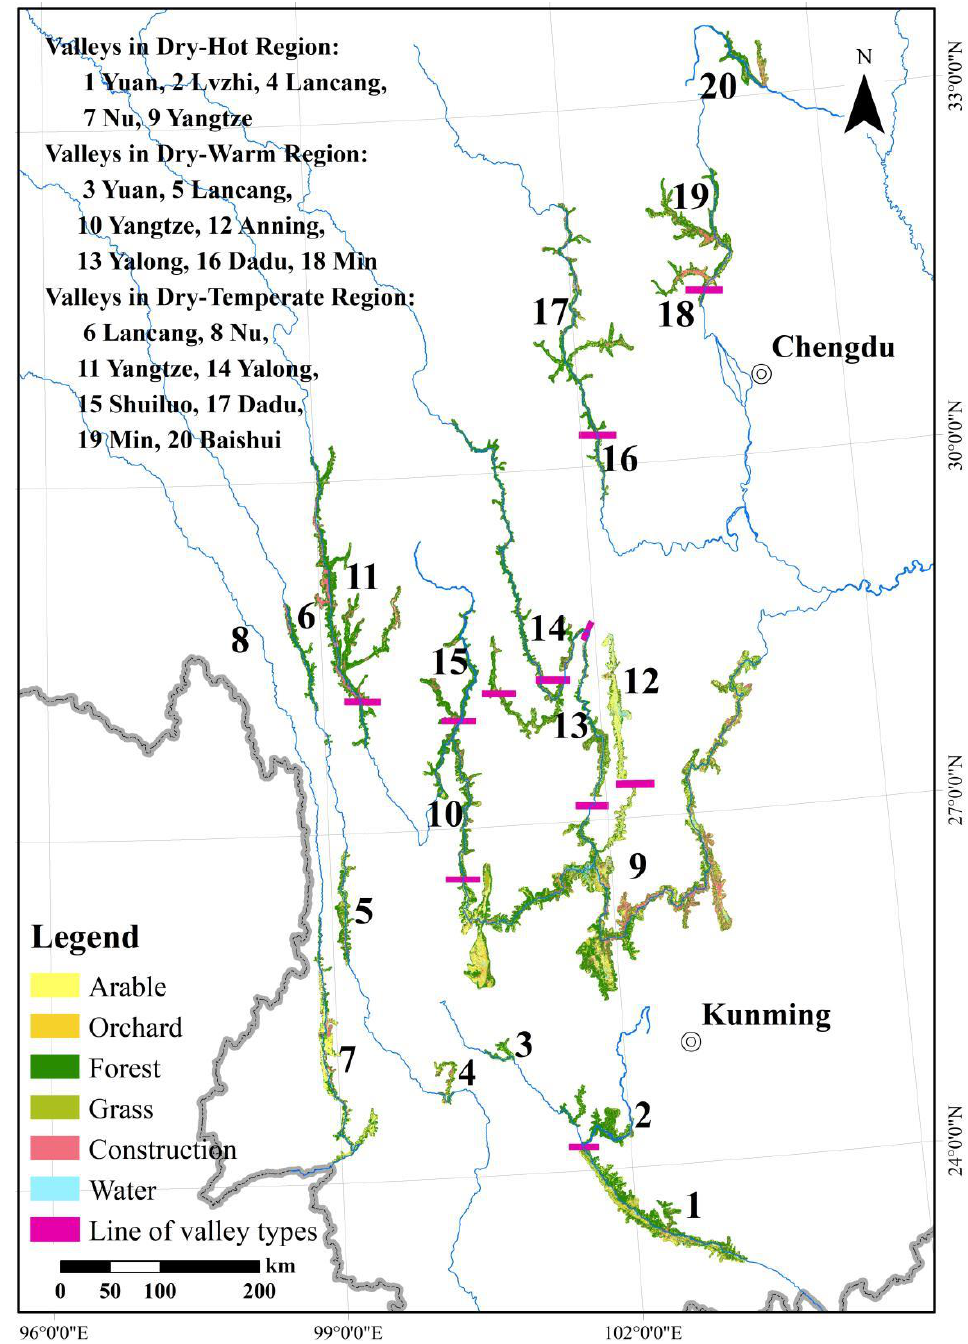
Figure 2. Spatial distribution of land use types in dry valleys of Southwest China. Table 3. Areas and proportions of land use types in dry valleys of Southwest China.